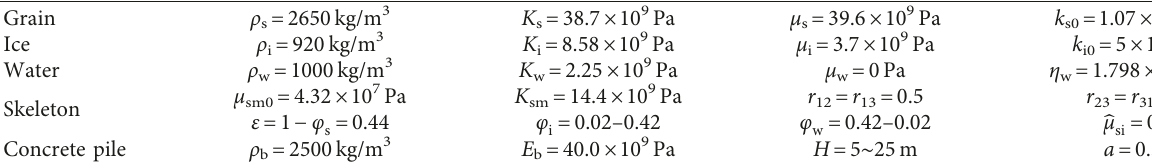
Figure 3: Two types of impact loads: (a) rectangle loading; (b) triangle loading. Table 1: Material properties of a pile in a frozen saturated porous